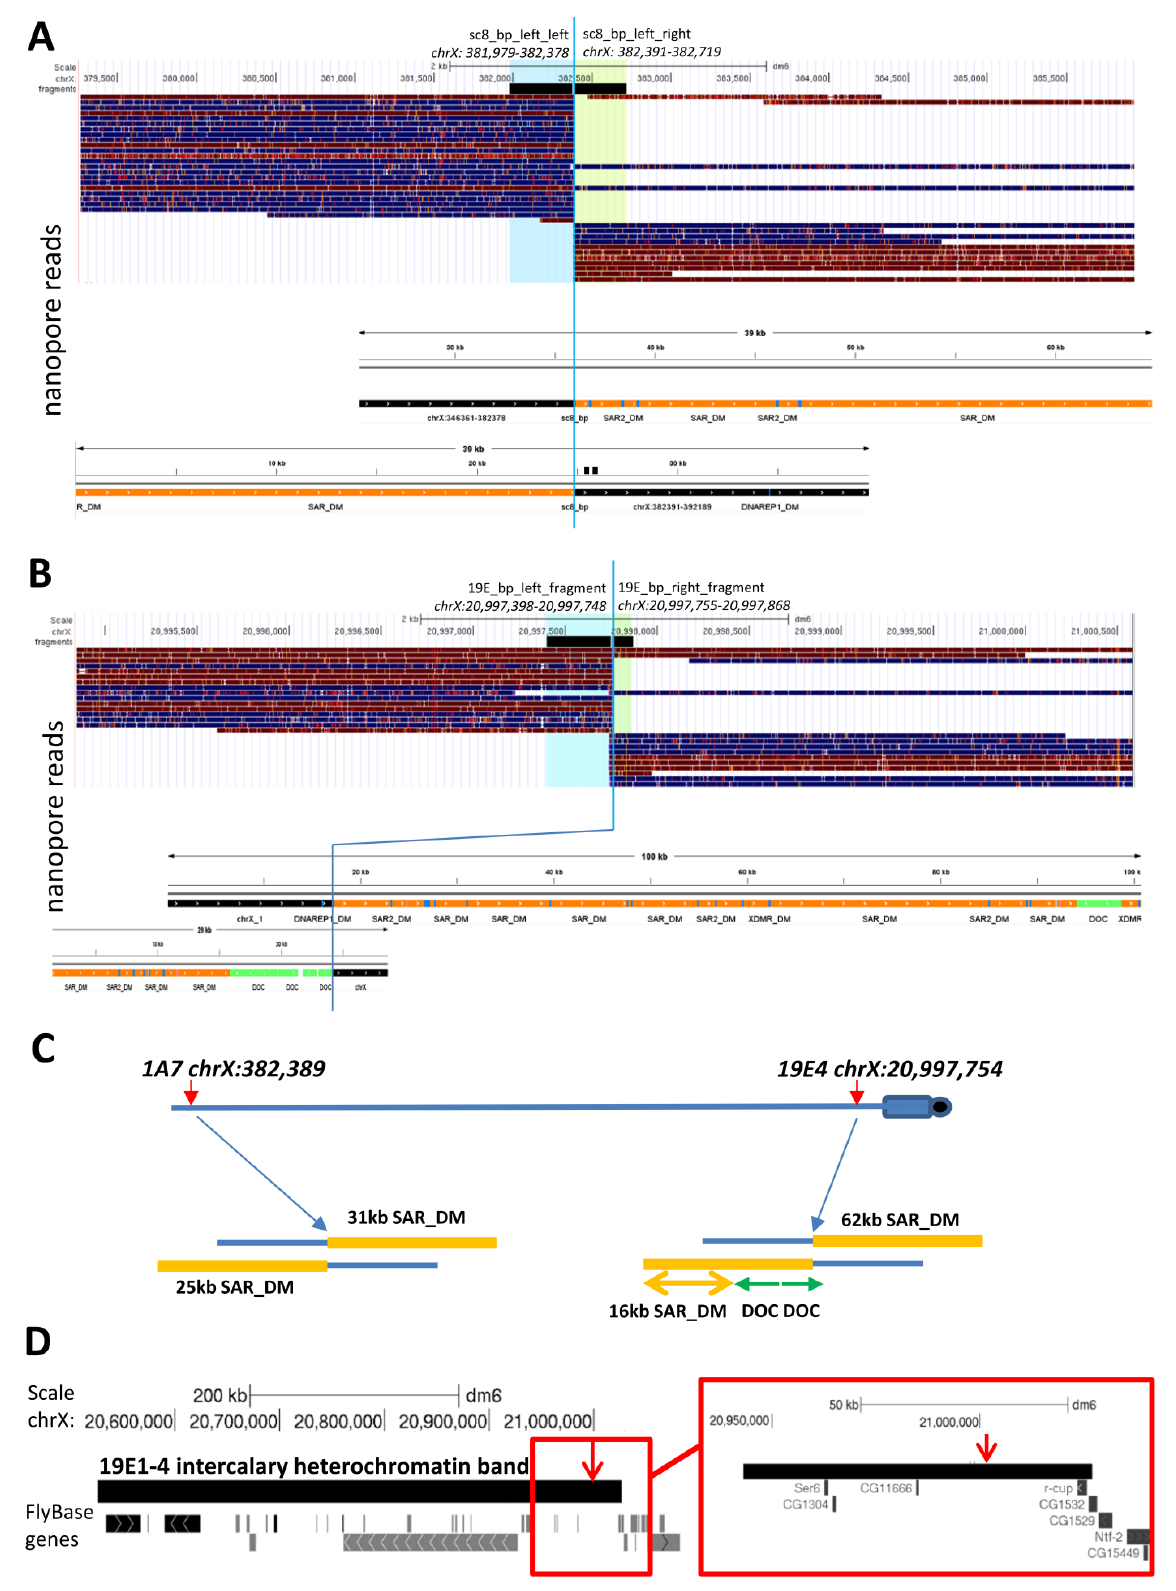
Figure 3. Elicitation of inversion breakpoints using nanopore sequencing. ( A ) Genome Browser view of the distal In(1)sc 8 breakpoint (blue line, chrX:382,384–382,389 ). Positions of two regions ( chrX: 381,979–382,378 and chrX: 382,391–382,719 ) used for extraction of nanopore reads are shown at the